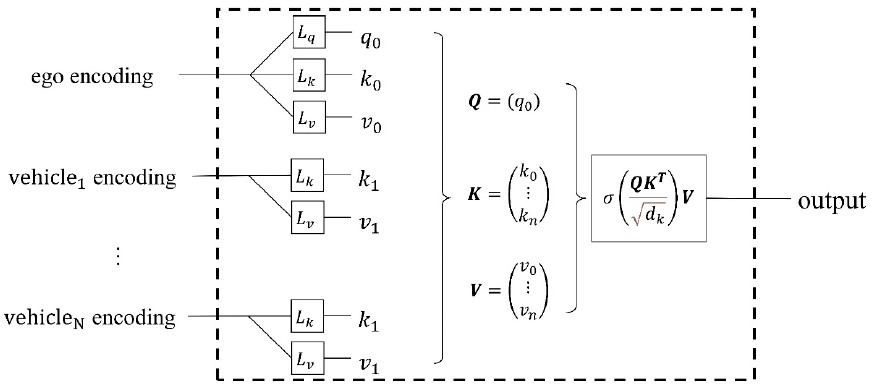
Figure 6. Self-attention network layer.